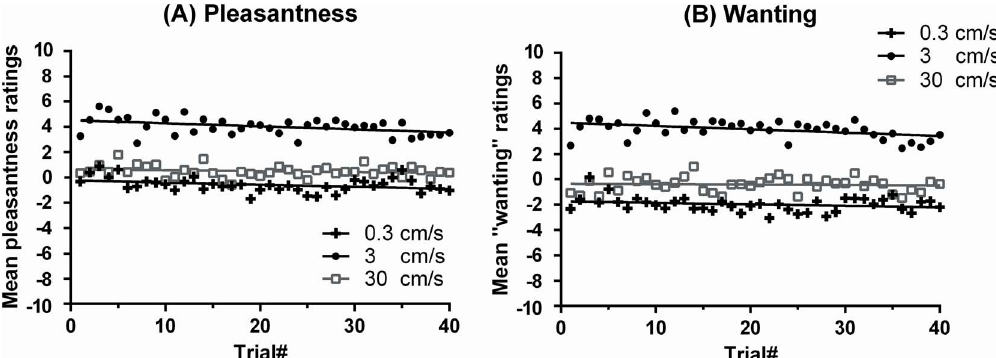
Figure 1. Ratings over time for (A) pleasantness and (B) wanting for stroking at different velocities in Experiment 1 (within- subjects). Significant decreases were found for the pleasantness and wanting of stroking at 3 cm/s over stroking repetitions; this decrease over time was not found for stroking at 0.3 and 30 cm/s. Furthermore, the pleasantness and wanting of touch was significantly higher for stroking at 3 cm/s, as compared to 0.3 or 30 cm/s.